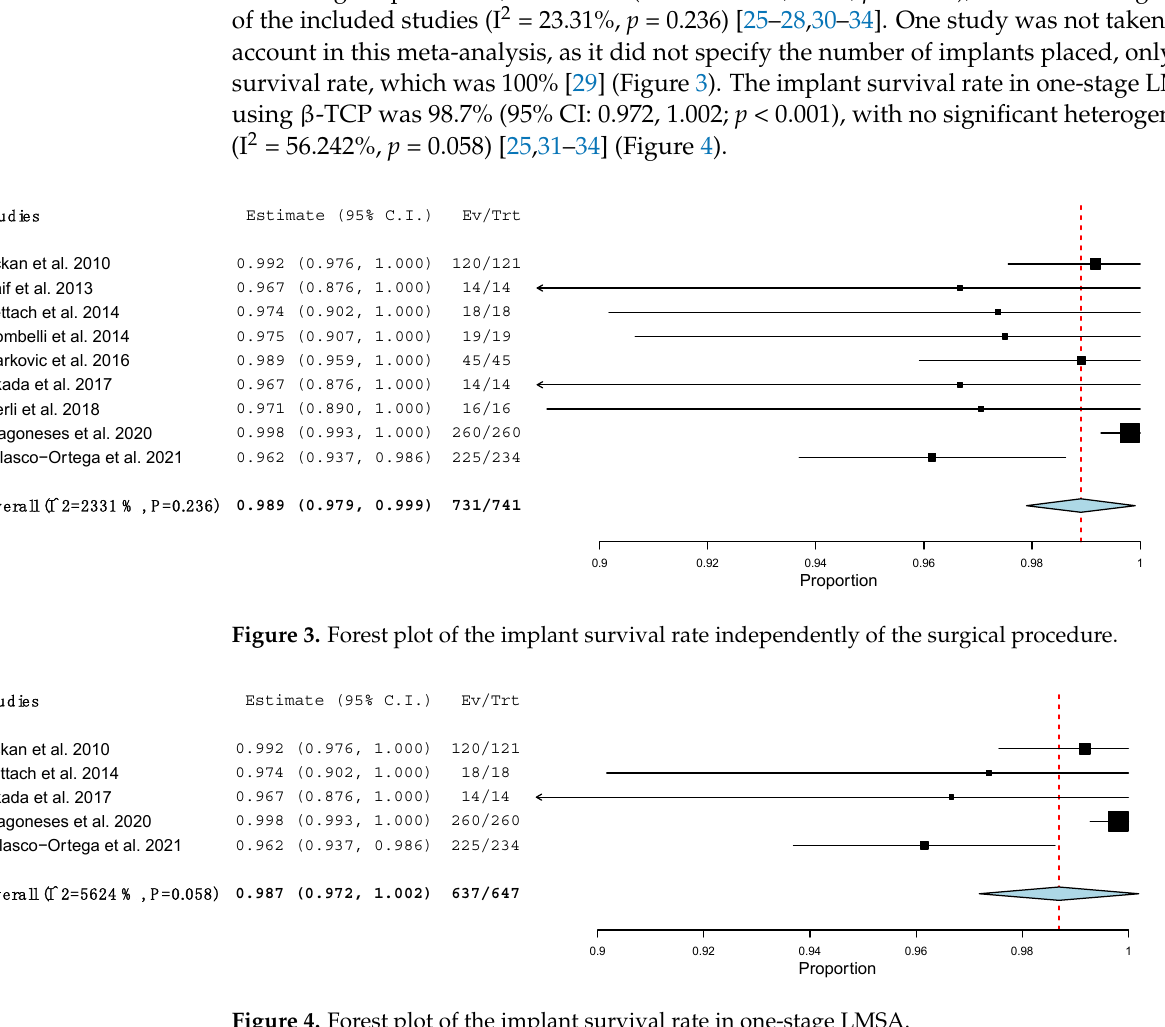
Figure 4. Forest plot of the implant survival rate in one-stage LMSA.